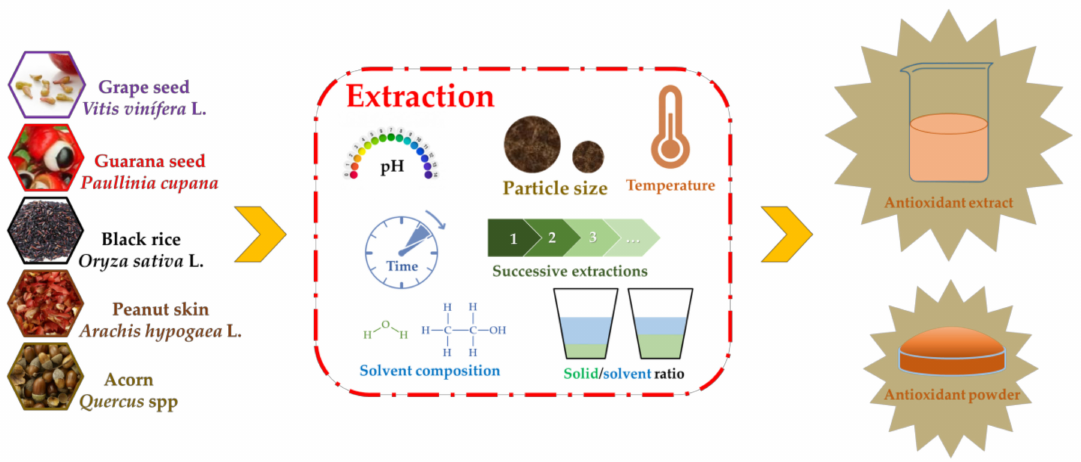
Figure 1. Factors a ff ecting the extraction of phenolic compounds from